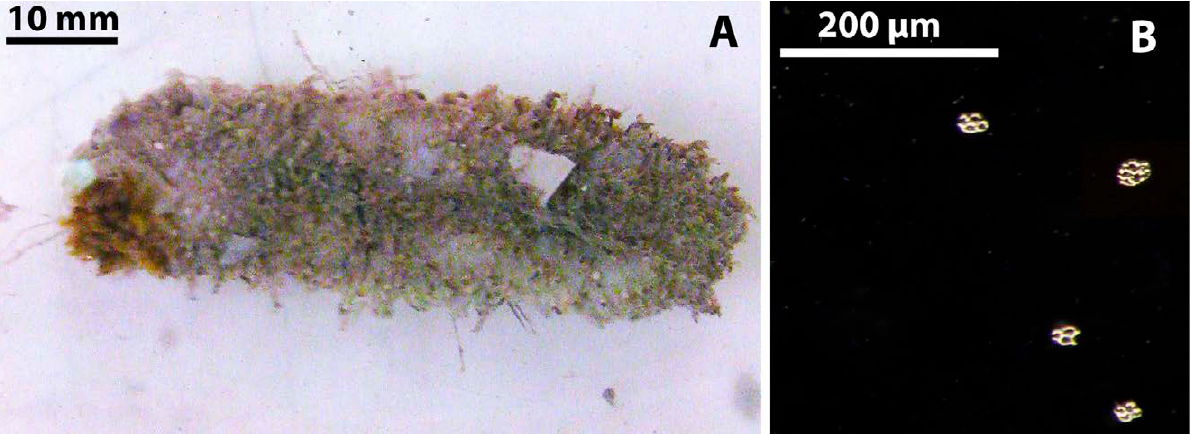
Fig. 9. – Holothuria ( Panningothuria ) forskali characteristics. A, general view; B,